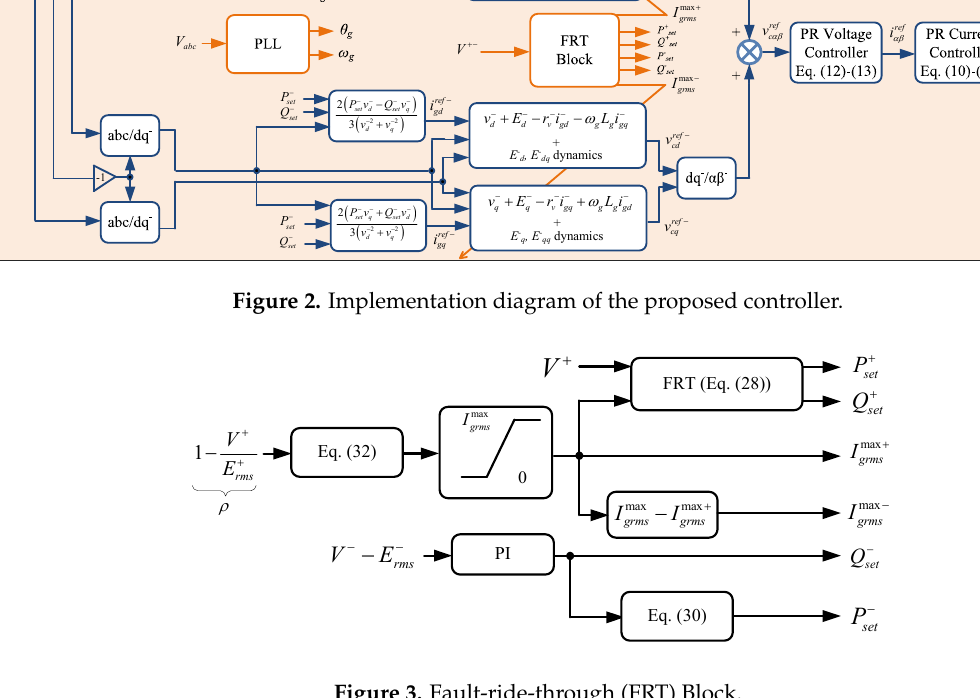
Figure 3. Fault-ride-through (FRT)